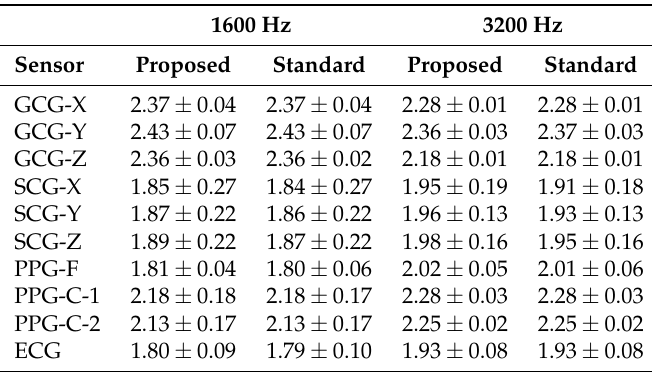
Table 2. Compression